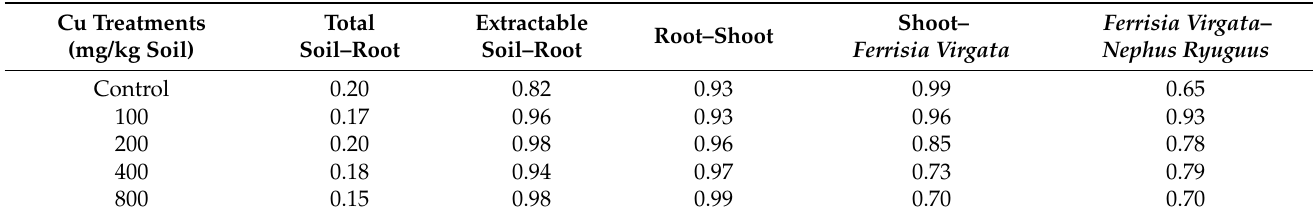
Table 1. Coefficients of Cu transfer between various components of soil–plant–mealybug–ladybird after soil amendment with